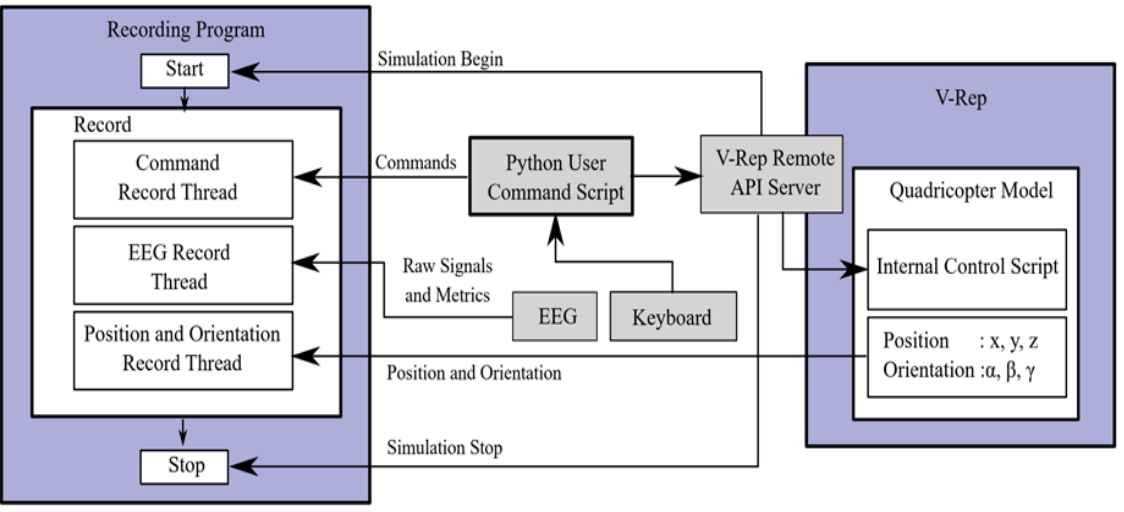
Figure 4. Recording program and simulation environment interaction.